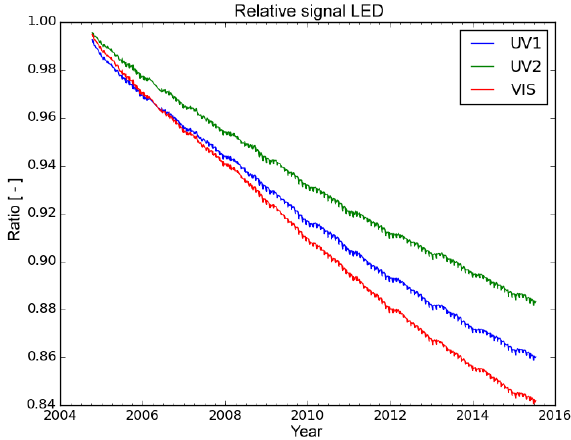
Figure 7. Signal change of WLS during the mission. Each data point shows a measurement divided by a reference measurement from the beginning of the mission. The three abrupt throughput changes in 2006–2009 are caused by the long (14min each) WLS duty